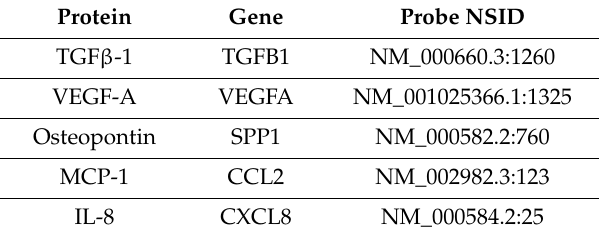
Table A2. Genes assessed by NanoString nCounter